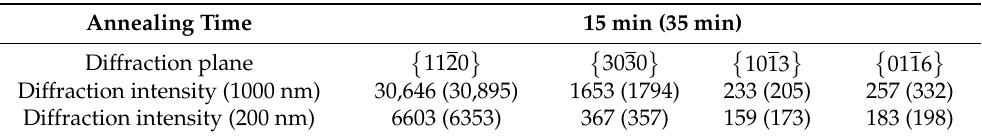
(cid:8) (cid:9) (cid:8) (cid:9) (cid:8) (cid:9) (cid:8) (cid:9) 1120 , 3030 , 1013 , and 0116 planes of 200 nm and 1000 nm